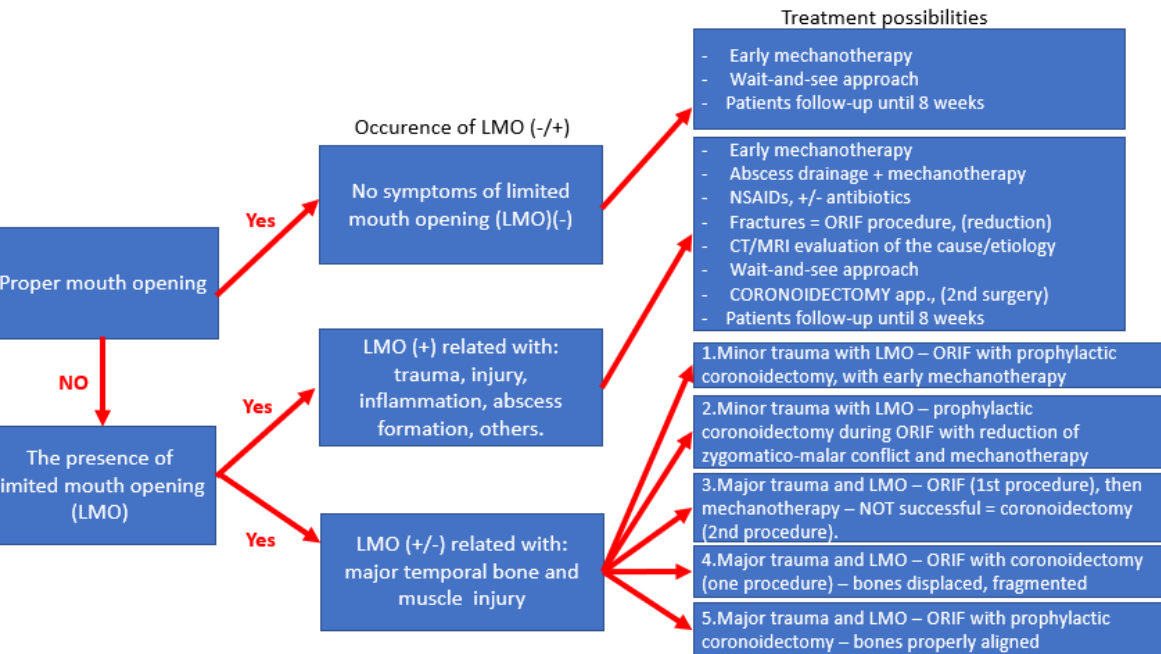
Figure 1. Authors proposed protocol on prophylactic coronoidectomy. The diagrams represent different clinical situations related to limited mouth opening (LMO). A major aspect should be with regard to the major injury in the temporal bone and muscle area. In some cases, displaced and fragmented bones might be a secondary cause of LMO, and despite their removal, a prophylactic coronoidectomy should be considered individually. Abbreviations: (+) present; ( − ) absent; (+/ − ) situation not clearly defined; NSAIDs — Non-Steroidal Anti-Inflammatory Drugs; app — approach; ORIF — open reduction and internal fixation (stable bone osteosynthesis).